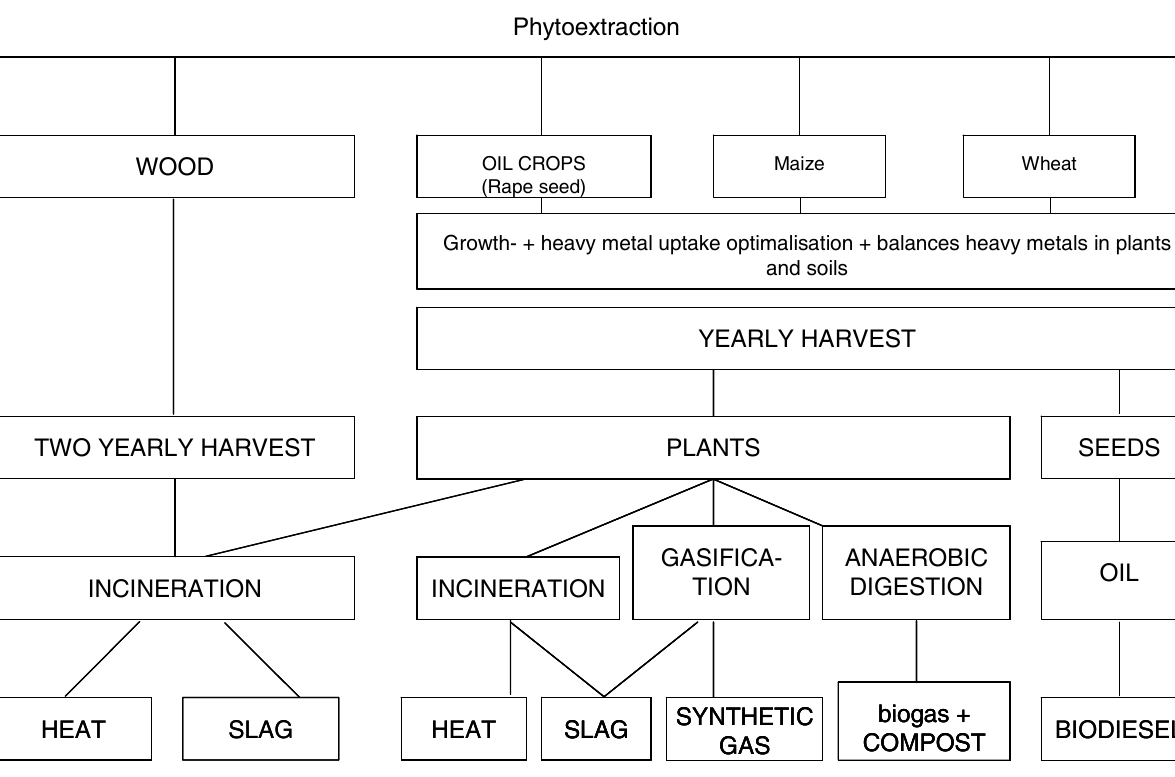
Fig 1. Representation of studied techniques to produce bioenergy from energy crops used in the remediation of soils contami- nated with heavy